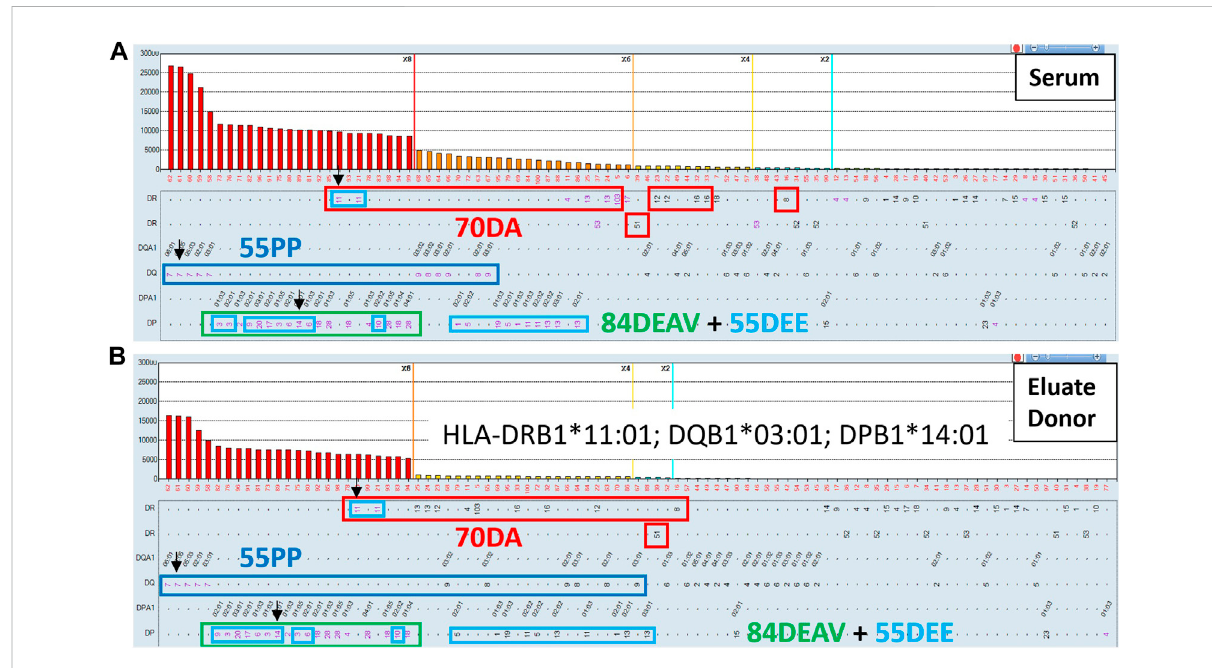
FIGURE 9 TheAXEprotocolallowsforaccuratecharacterizationofclassIIHLAantibodypatternsincludingweakantibodyreactivities.SABimagesofClass II HLA speci fi cities in a sensitized patient ’ s serum (A) and the AXE eluate using cells from a surrogate donor (B) , are shown. Mean fl uorescence intensity (MFI) values are displayed on the Y axis. The SAB HLA speci fi cities ( X axis) are sorted in order of decreasing MFI. Mismatched AXE donor speci fi c antigens are listed in panel B and are indicated with black arrows (A and B) . HLA antigens expressing the relevant mismatched donor eplets: (70DA red, 55 PP dark blue, 55DEE light blue and 84DEAV green rectangles) are